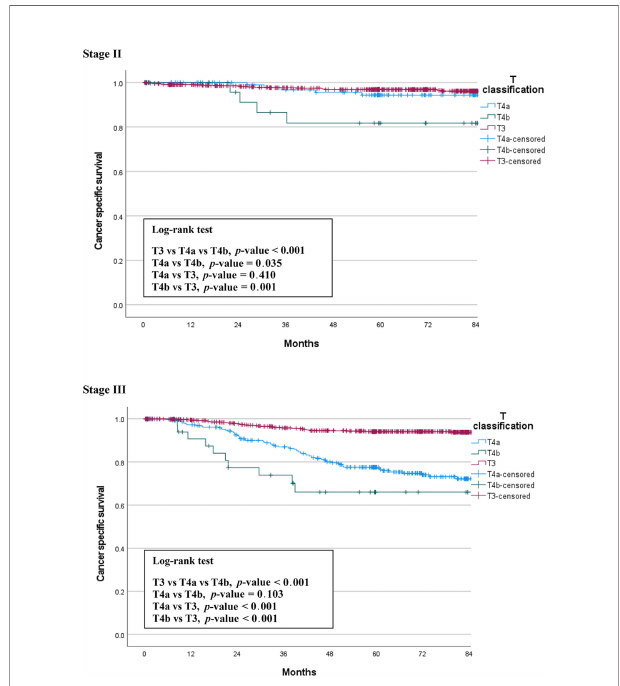
FIGURE 2 | Cancer-speci fi c survival of T3 vs. T4 patients by